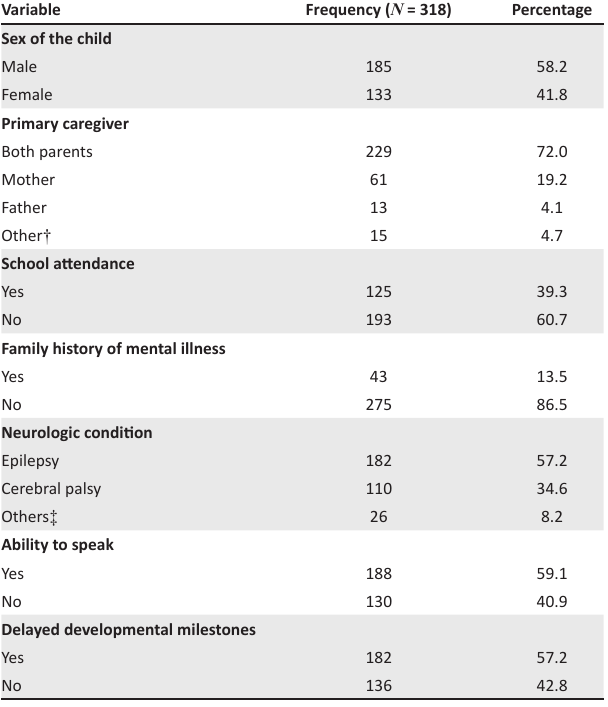
TABLE 1: Socio-demographic and clinical characteristics of participants. Variable